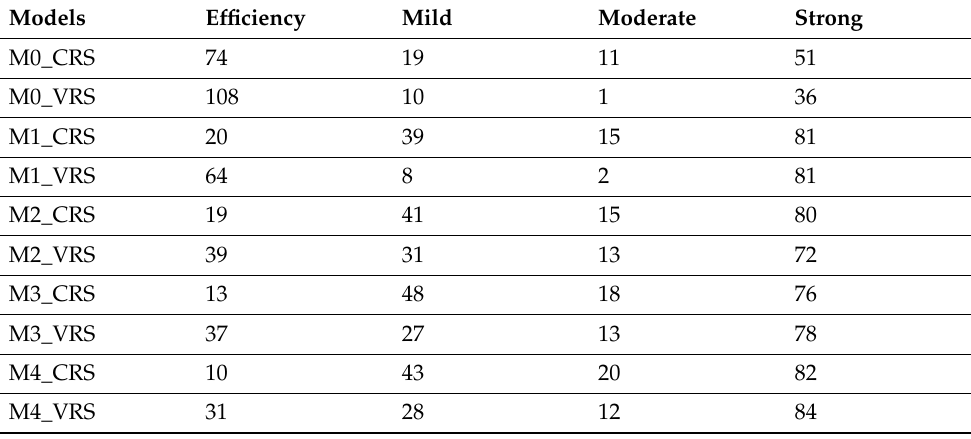
Table 7. Efficient, mild inefficient, moderate inefficient, and strong inefficient health centers.